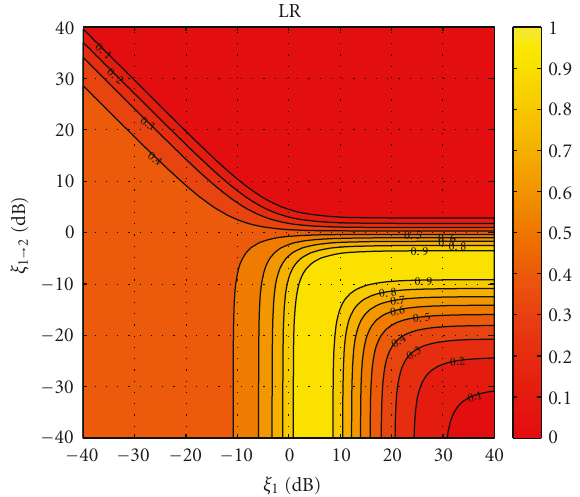
Figure 6: Contour plot of the likelihood ratio (15) assuming a noise power rise from block 1 to block 2 ( σ 2 N a priori SNR in block 1, ξ 1 → 2 the step of the a priori SNR at the transition from block 1 to 2.